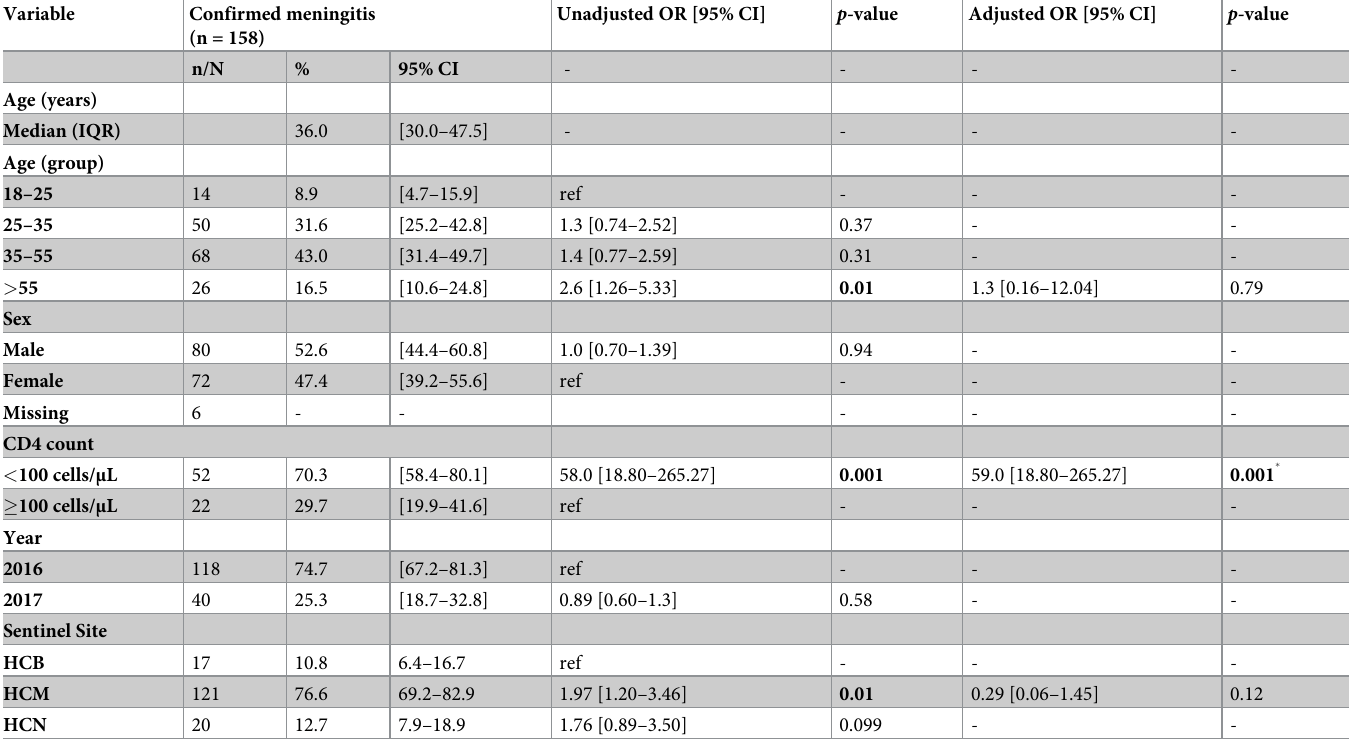
Table 3. Univariate and multivariate logistic model for predictors of meningitis among adult patients in Mozambique,